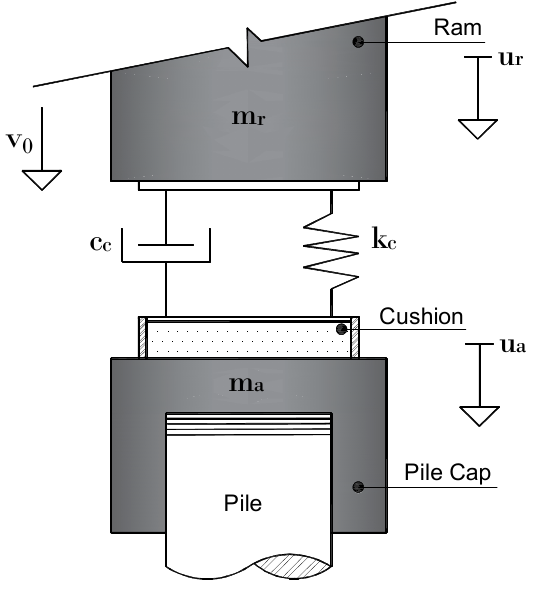
Figure 3. Two degrees-of-freedom pile–hammer model.